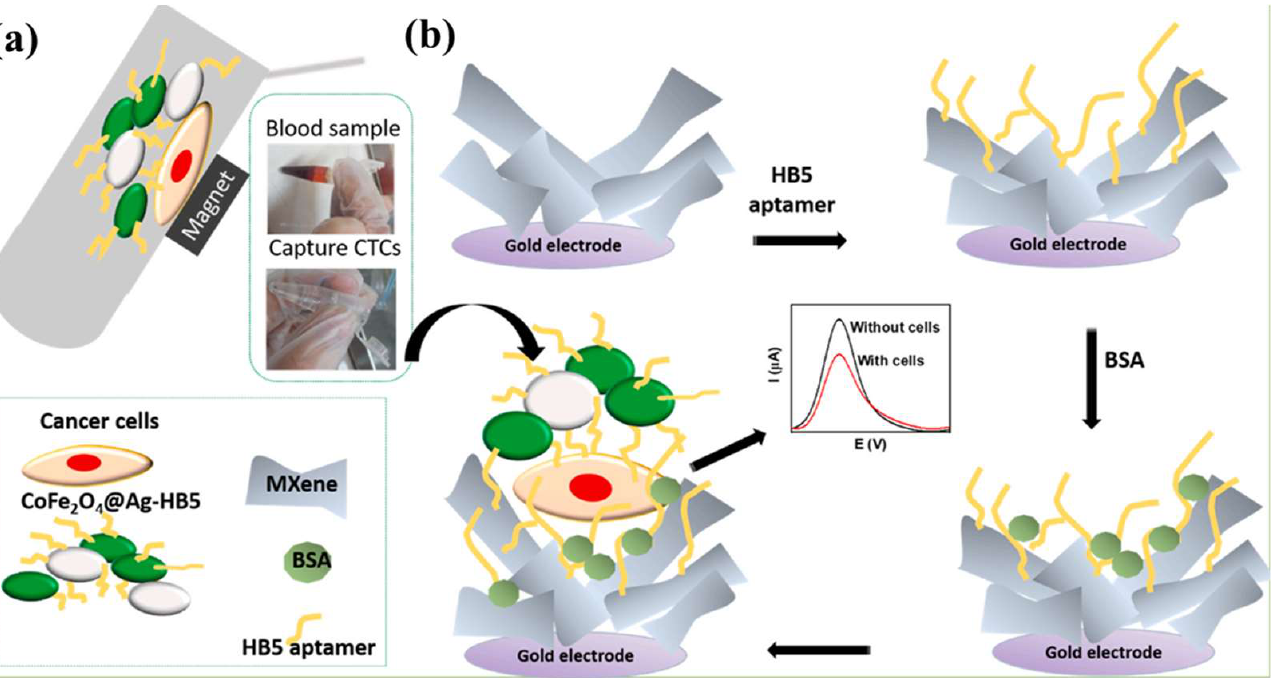
Figure 10. Schematic illustration of an MXene-based cytosensor for the detection of SK-BR-3 cells: ( a ) Magnetic cell isolation using CoFe 2 O 4 @Ag-HB5, ( b ) Electrochemical cell detection on a function- alized MXene-based surface (Reprinted with permission from Ref. [138]. Copyright 2022, Elsevier).